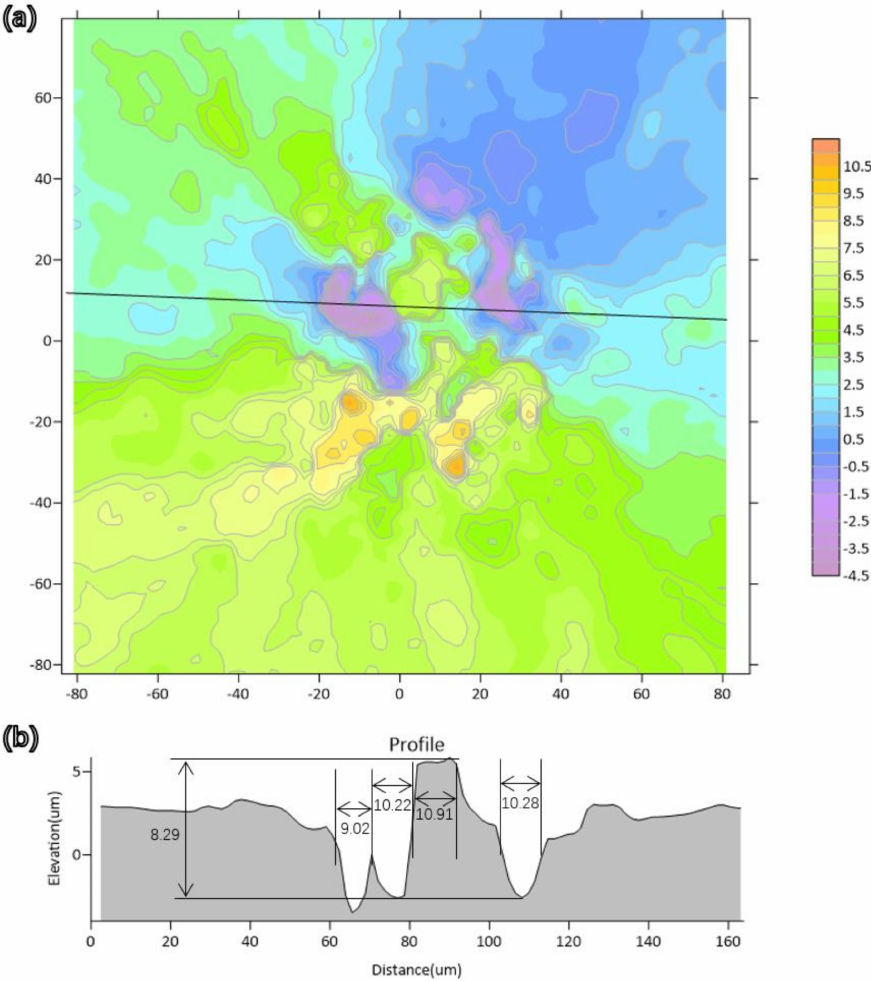
Figure 11. 3D morphology scanning and profile of RA: ( a ) contour of RA, ( b ) profile of the cut line. There is a series of valleys and peaks in the RA and the average distance of a valley or peak is 10.11 µ